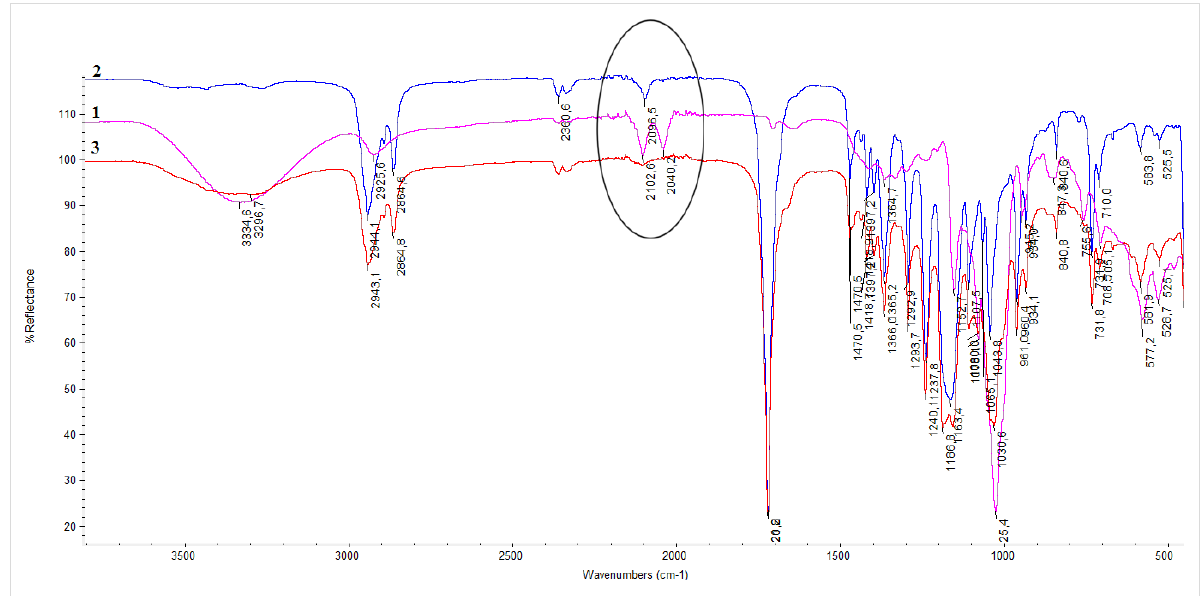
(43.806 mmol, 10 Eg) of ε -caprolactone and 608.86 mg of propargylic alcohol was added to the round-bottom flask and heated at 120 °C. When the temperature is reached, 88.72 mg (0.219 mmol) of Sn(Oct) 2 , 0.5 mol % with respect to the mono- mer, is added. Argon was purged into the reaction flask. The reaction mixture was stirred for 24 h. After this, the product was cooled at room temperature and a solid is formed. The product was dissolved in CH 2 Cl 2 , separated through precipitation in a large excess of hexane, and dried under vacuum (91% mass yield). The reaction product was characterized in terms of mole- cular weight and dispersity by GPC and the obtained values were 4600 for the Mw and 1,164 for the dispersity index. The structure was proved by NMR. 1 H NMR (600 MHz, CDCl 3